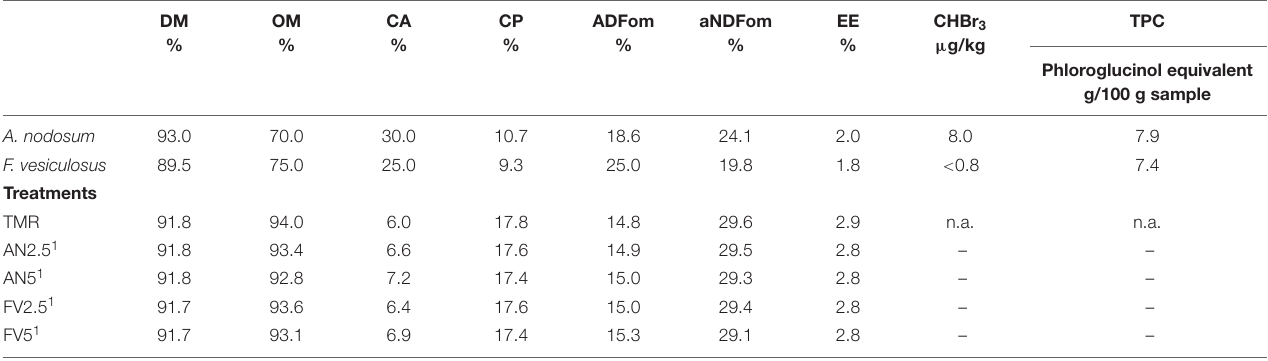
TABLE 1 | Nutrient composition, bromoform, total phenolic content of the used seaweeds, and five experimental diets.